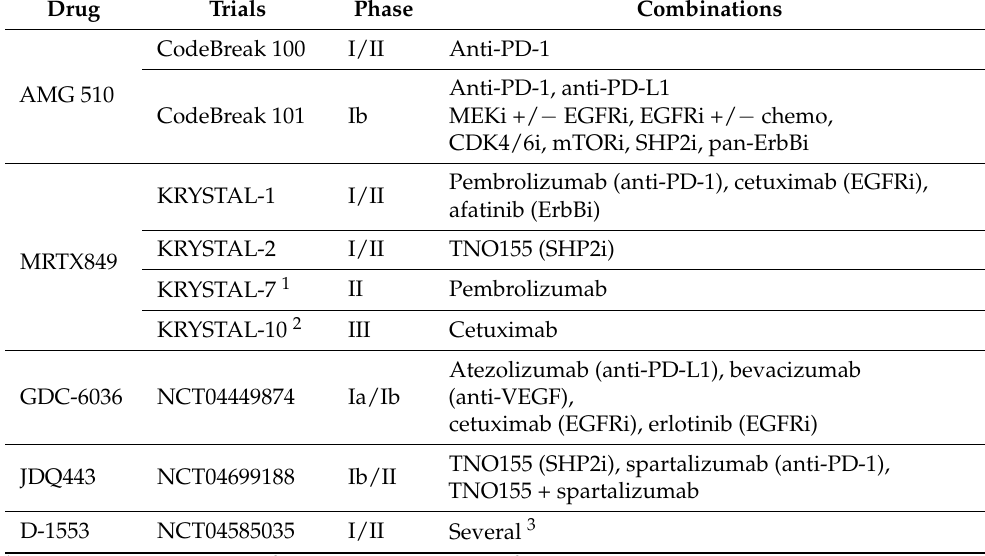
Table 2. KRAS-G12C inhibitor trials with combination